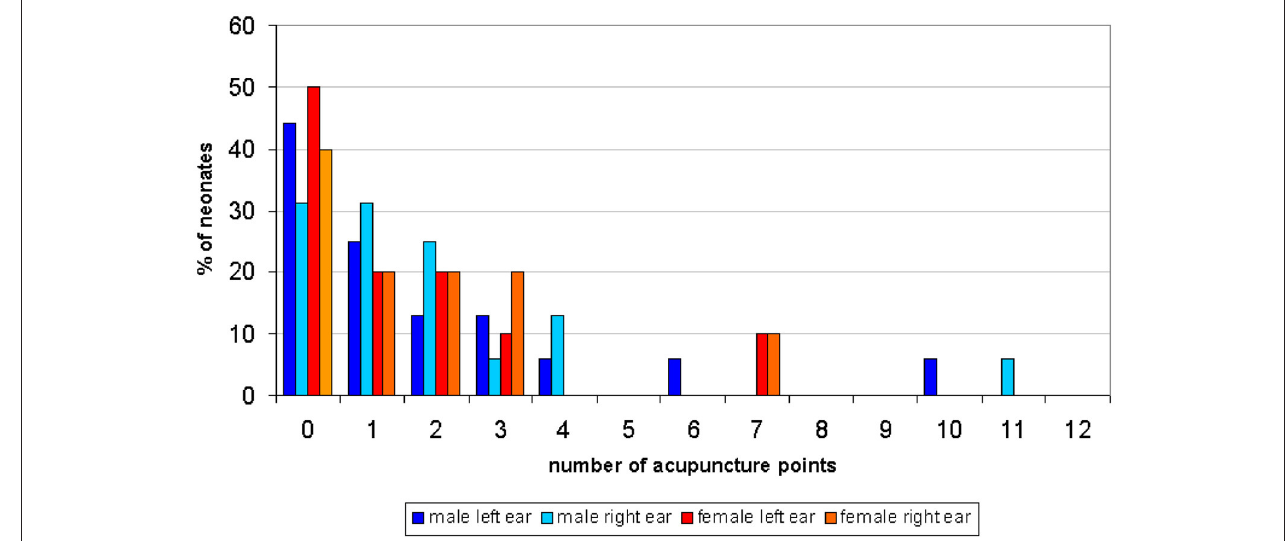
FIGURE 1 | Demonstrates the number of active ear points in comparison to male and female